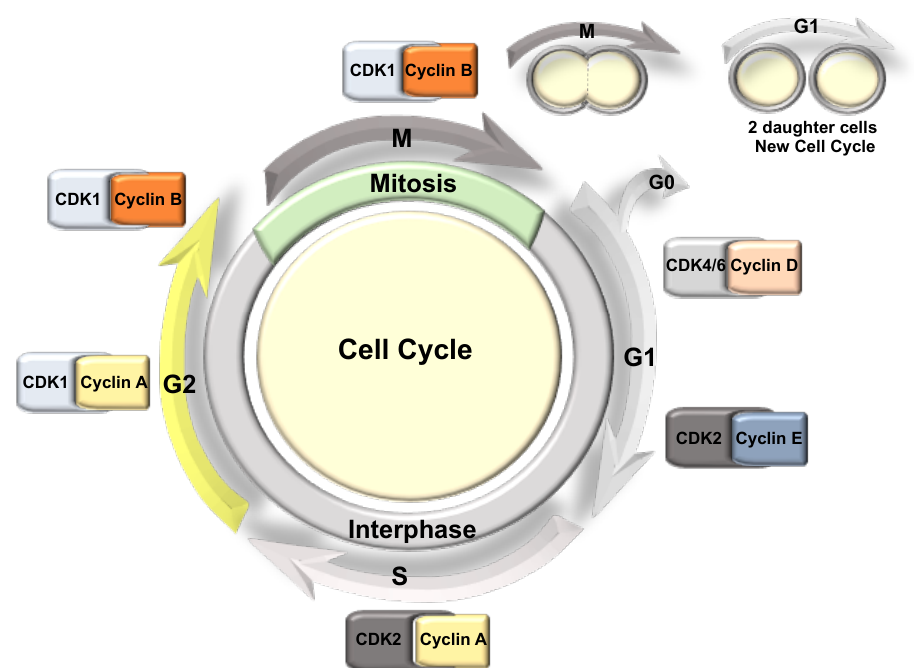
Figure 2. The mammalian cell cycle phases. The cell cycle is divided into two main phases: interphase that includes G1, S, and G2, and mitosis. Each of these stages is associated with a CDK/Cyclin pair, controlling the progression of the cell cycle.